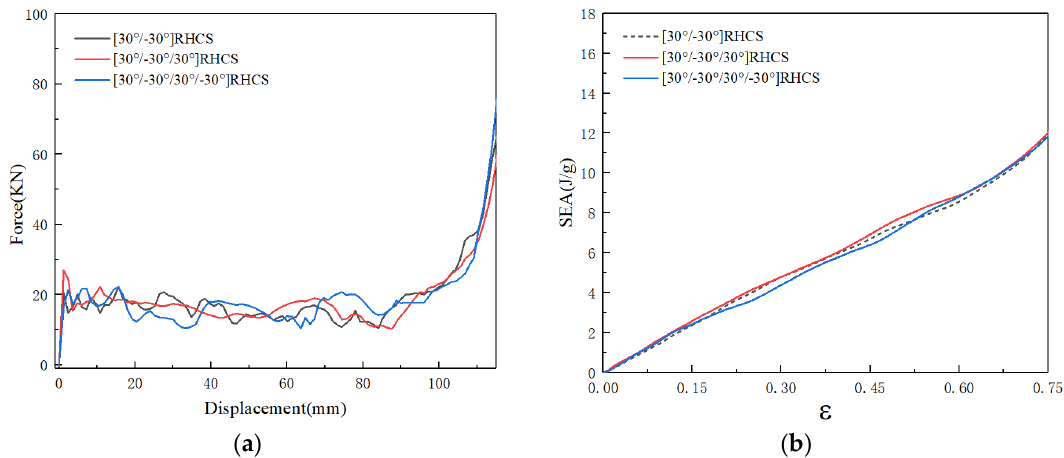
Figure 23. The deformation modes of multi-layer composite RHCSs under low velocity: ( a ) [30°/ − 30°/30°] RHCS; ( b ) [30°/ − 30°/30°/ − 30°] RHCS.